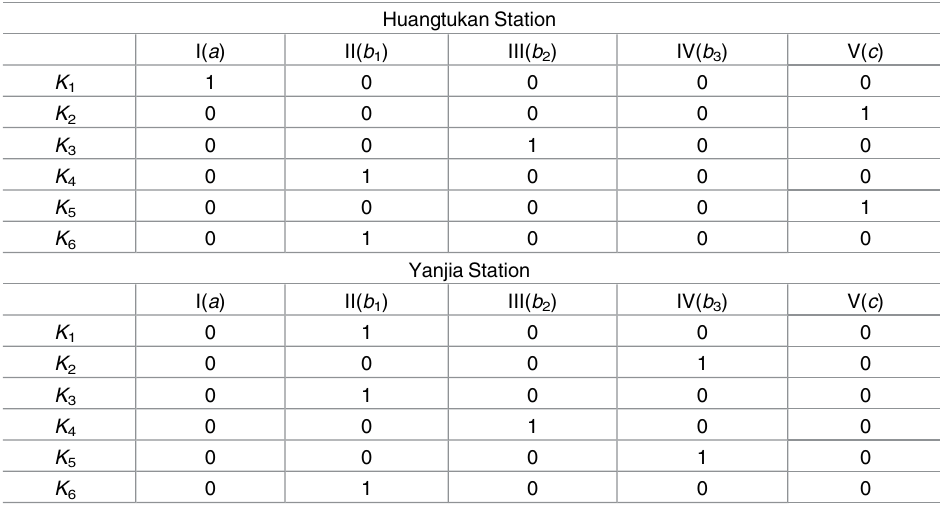
Table 7. Evaluations for each hazard